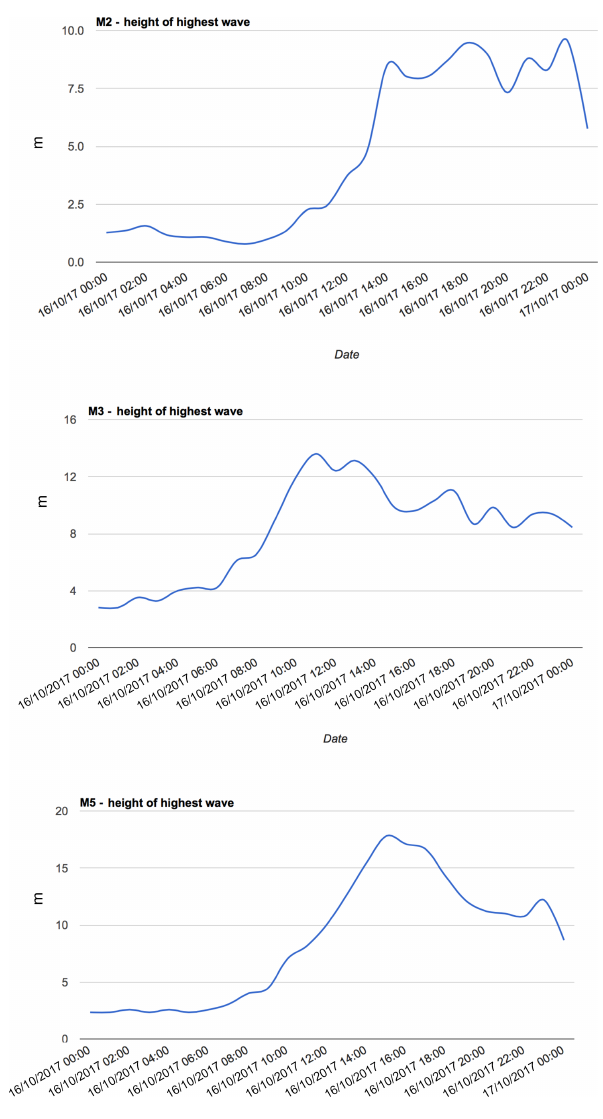
Figure 11. Maximum wave height recordings on the M2, M3 and M5 buoys during Storm Ophelia on 16 October 2017. The largest waves recorded were 9 . 6m (M2), 13 . 6M (M3) and 17 . 8m (M5). Data retrieved from The Marine Institute (2017a).